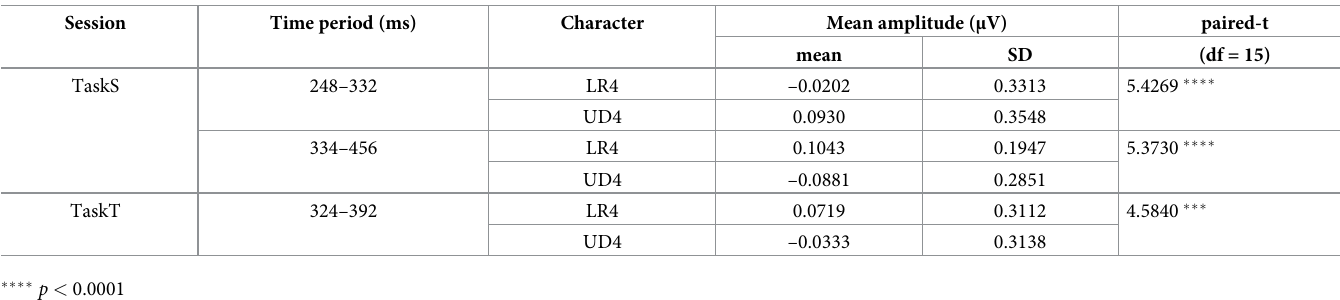
Table 5. Effects of IC5 reflecting extraction of abstract structural pattern.